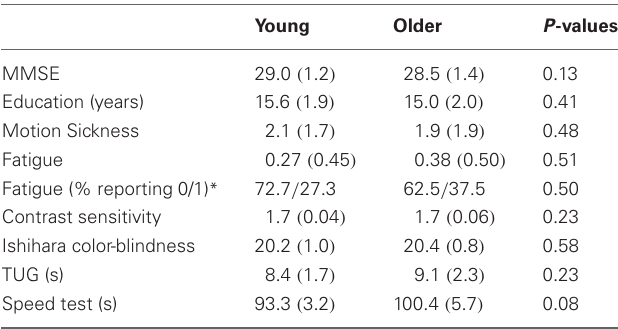
Table 2 | Mean (SD) for screening assessments in young and older